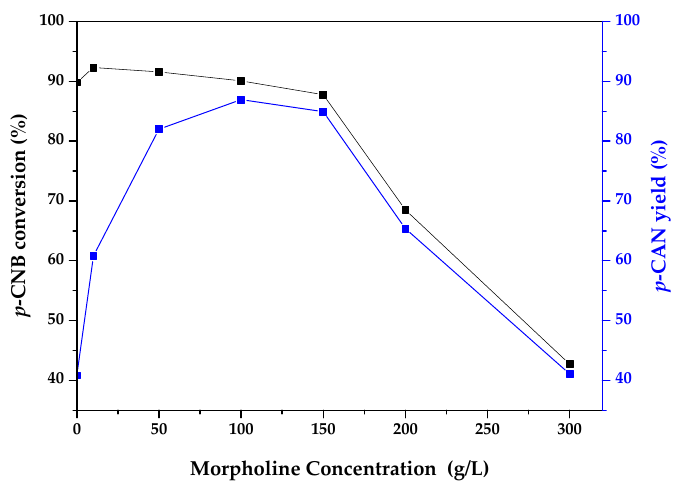
Figure 10. Impact of morpholine concentration on the conversion (black) and selectivity (blue) of catalytic hydrogenation of p -CNB. Reaction conditions: 1 g catalyst, 1 g p -CNB dissolved in 50 mL ethanol, 80 ◦ C, 600 rpm, 2 MPa H 2 pressure, and 4 h in a 100 mL